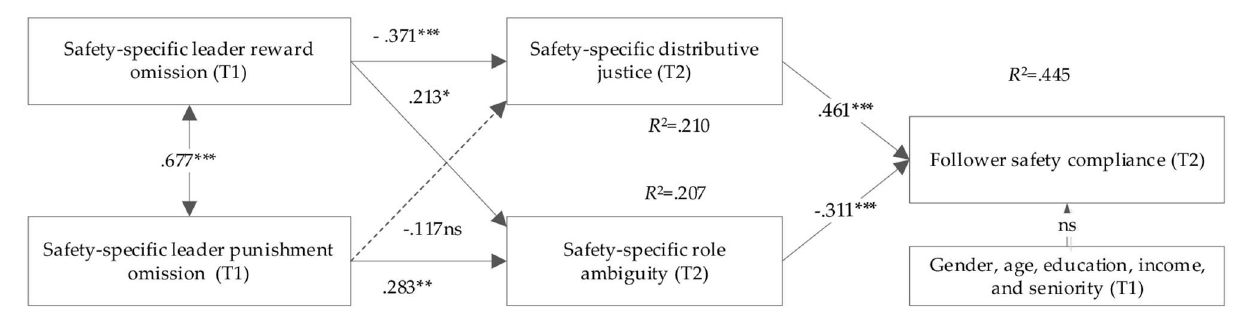
Frontiers in Public Health |